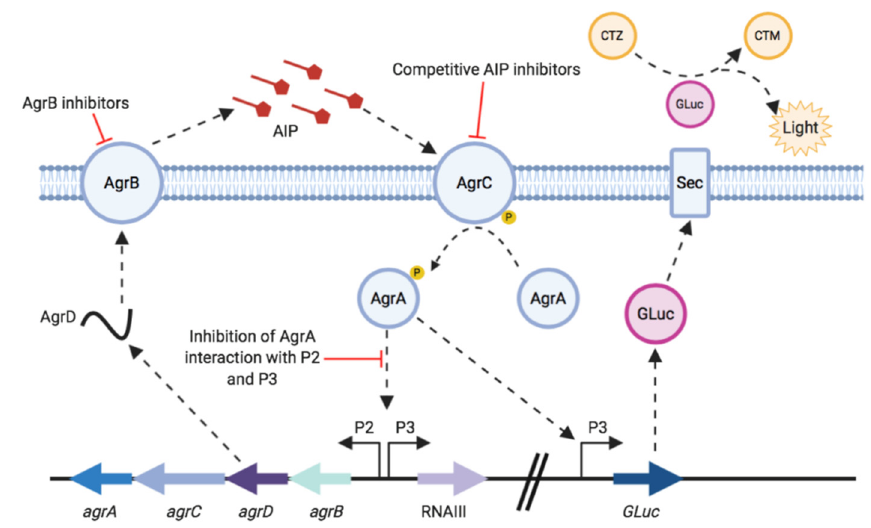
Figure 1. Outline of the staphylococcal agr system and the P3 GLuc reporter. Critical control points of the agr system, which are amenable to targeting by inhibitors, are indicated by blunt arrows. CTZ represents coelenterazine and CTM coelenteramide. Adapted from [13].